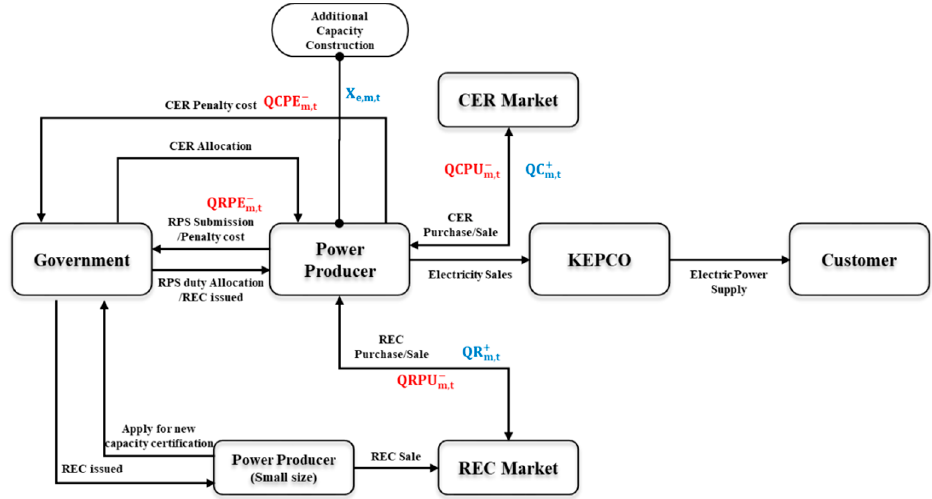
Figure 4. Problem structure.